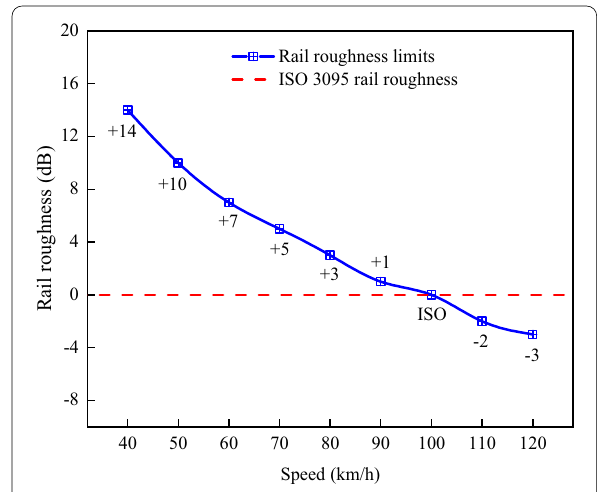
Figure 14 Rail roughness acceptance criteria for all-wavelength band at different speeds